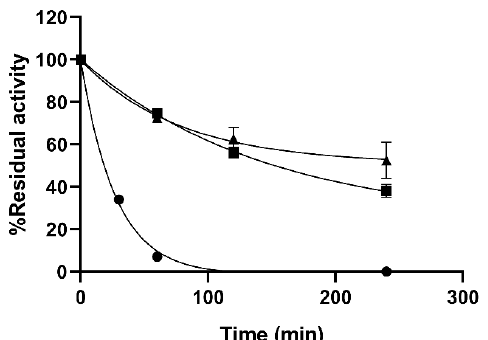
Figure 2. Thermal stability of b ‐ Glc preparations at 75 °C. Soluble b ‐ Glc (circles), b ‐ Glc immobilized onto aminated (100 nm) MNPs (MNP Amine—triangles), b ‐ Glc immobilized onto oxidized carboxylated MNPs (MNP